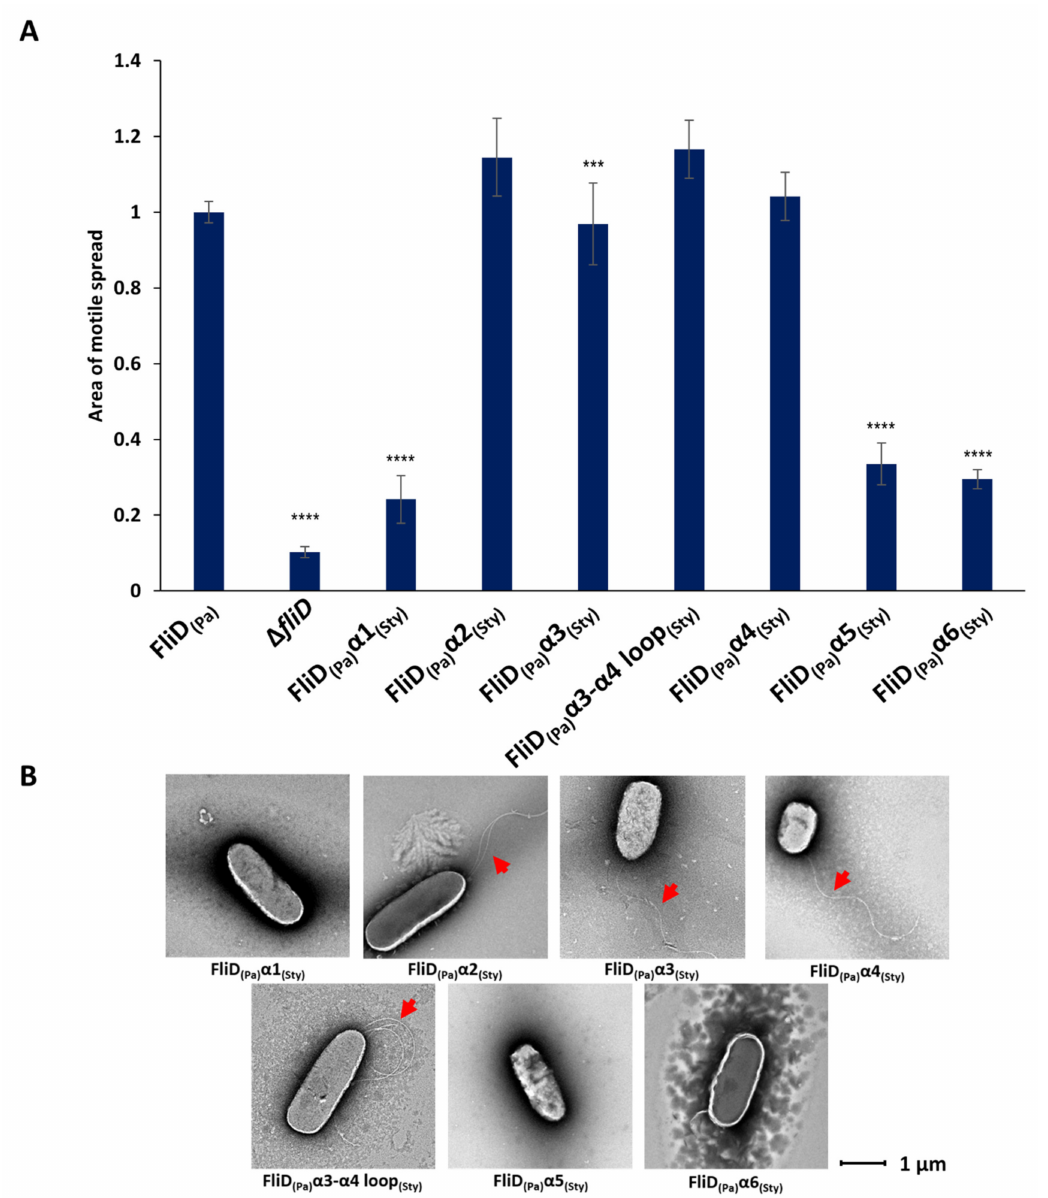
Figure 3. Effects of FliD D1 helical swaps in flagellar formation and function. ( A ) Swimming motility analysis and ( B ) negative-stain EM images of knockout and complemented Pseudomonas aeruginosa PAO1 strains. Origin of each helix ( α 1, α 2, α 3, α 3- α 4 loop, α 4, α 5, α 6) in the chimeric fliD gene in each complement is indicated. Area of motile spread for each strain is normalized to that of the full-length wild type complemented strain [ Pa ∆ fliD / fliD Pa (1-474)]. (*** p < 0.001; **** p <